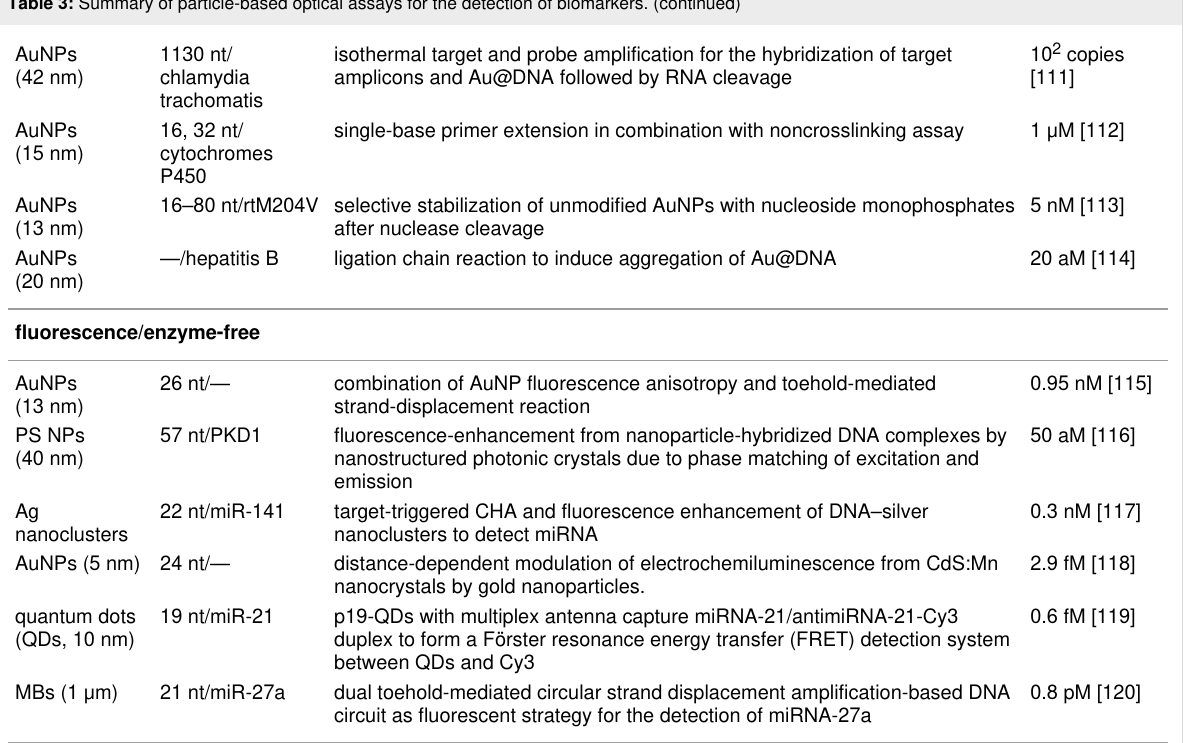
Table 3: Summary of particle-based optical assays for the detection of biomarkers. (continued) AuNPs 1130 nt/ isothermal target and probe amplification for the hybridization of target (42 nm) chlamydia amplicons and Au@DNA followed by RNA cleavage trachomatis